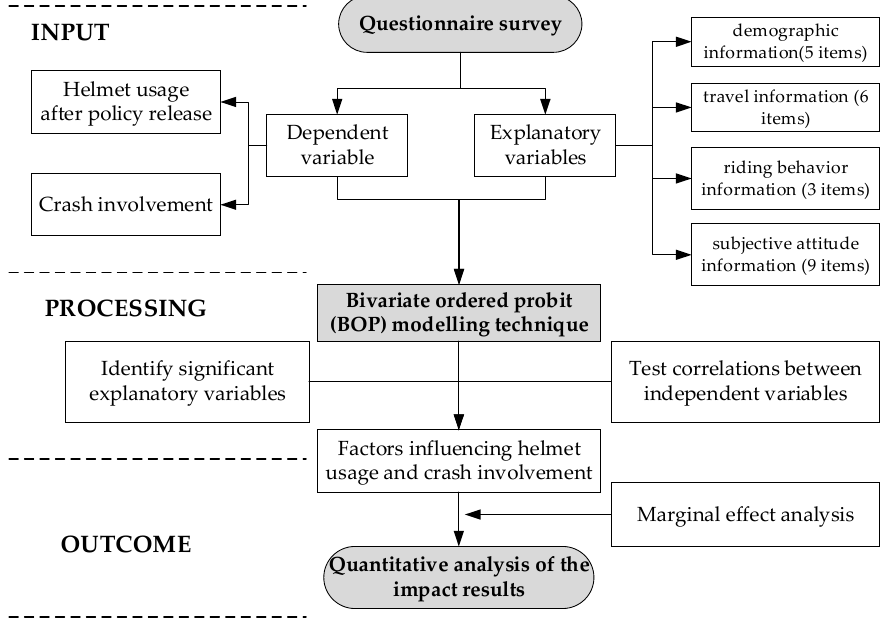
Figure 4. Detailed calculation process and steps.